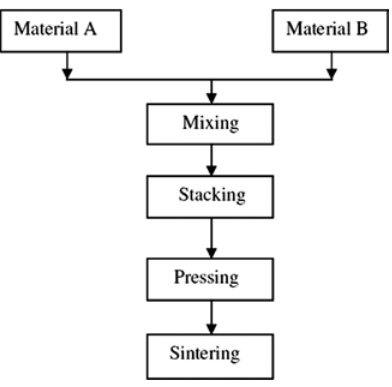
Figure 1: Flowchart of the powder metallurgy